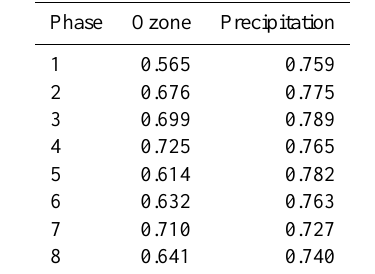
Table 1. Longitude–latitude (30 ◦ S–30 ◦ N) spatial correlation co- efficients between modeled and measured ozone and precipitation anomalies, correlated for each phase of the MJO between CAM- chem and TES tropospheric ozone column (324 points) and CAM- chem and TRMM precipitation (4608 points). All correlation coef- ficients pass the Student’s t test at 95% confidence